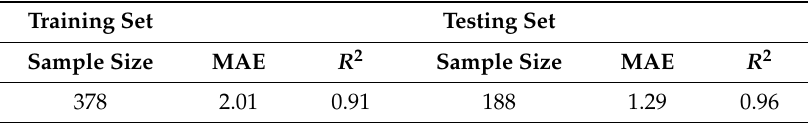
Table 3. Prediction result of random